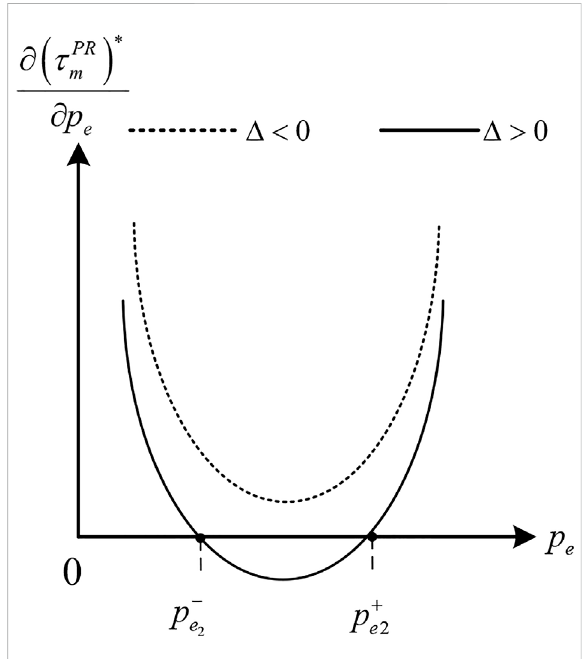
FIGURE 4 The fi rst partial derivative of the emissions reduction level with respect to p e under strategy PR.